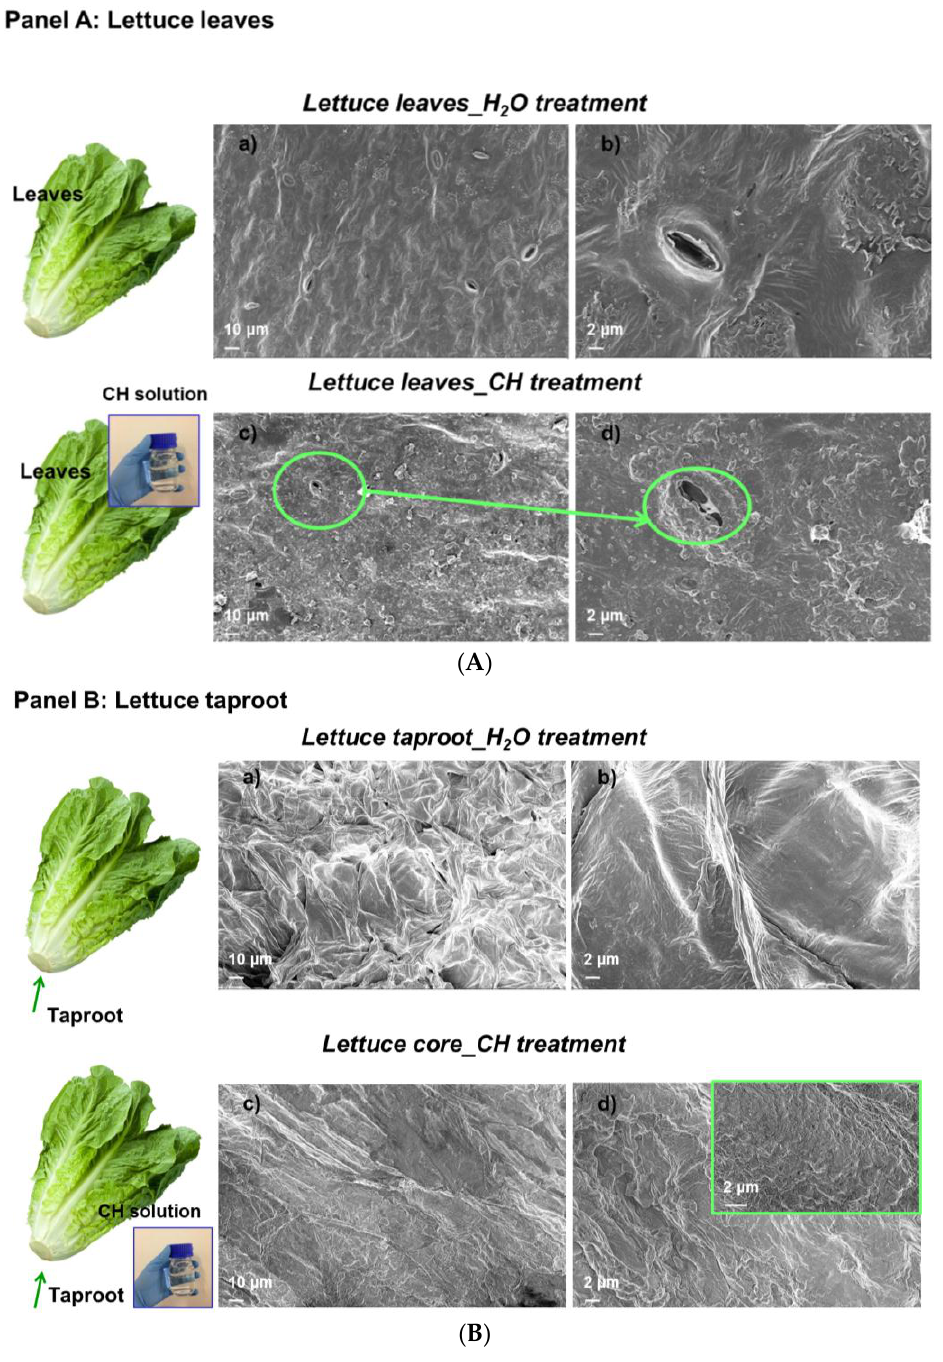
Figure 3. Evidence of CH coating on ( A ) lettuce leaves and ( B ) lettuce taproot treated with ( a , b ) water as control and with ( c , d ) CH solution.